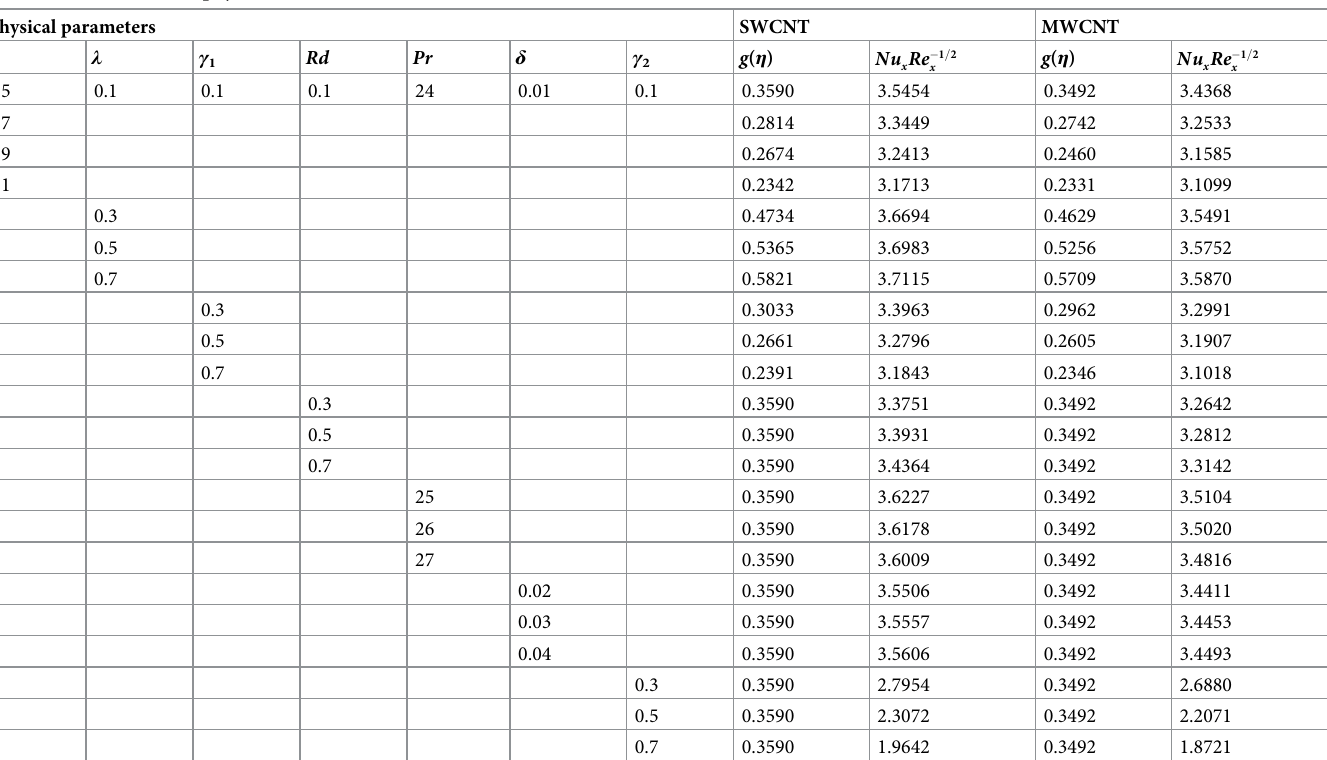
Table 3. Effect of distinct physical factors on the skin frictions and Nusselt number. Physical parameters